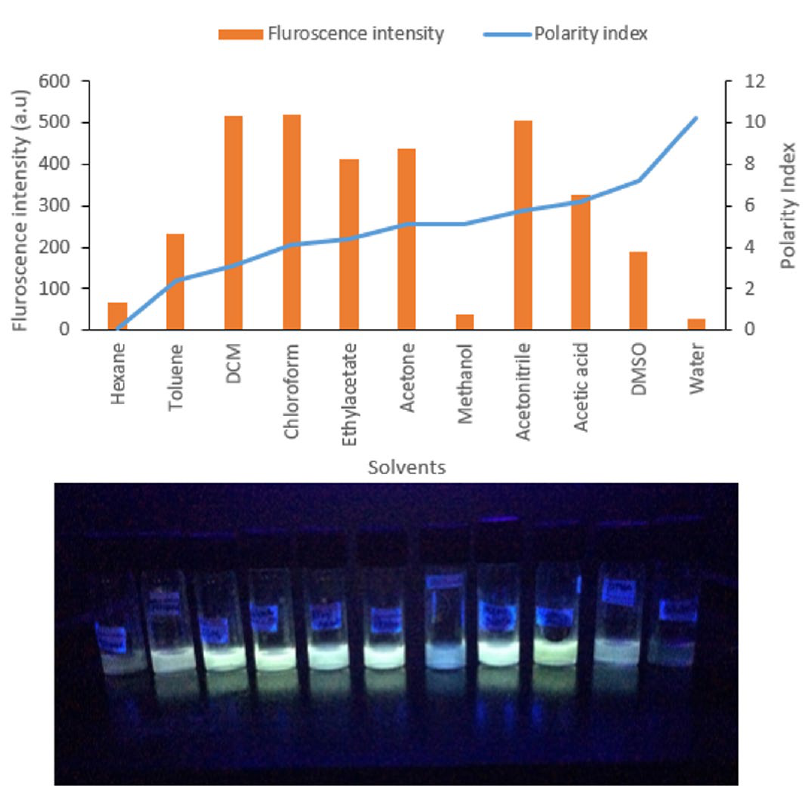
Fig. 6. (A) Graph summarises the solvatochromism analysis exhibited in different solvents. (B) The fluorescence exhibited in solvents was